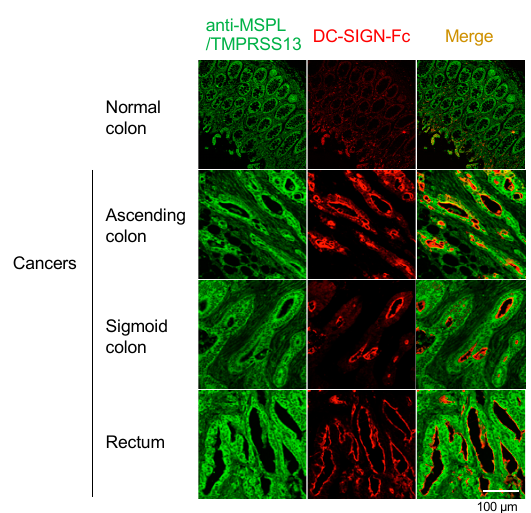
Figure 2. Expression of MSPL/TMPRSS13 in human colorectal carcinoma tissues. The expression of MSPL/TMPRSS13 (green) and DC-SIGN ligands (red) was visualized through laser confocal microscopy. Yellow fluorescence indicates merged green and red signals, as shown in the right panels. Nomarski images are shown on the right side of each panel. Scale bars, 100 µm.